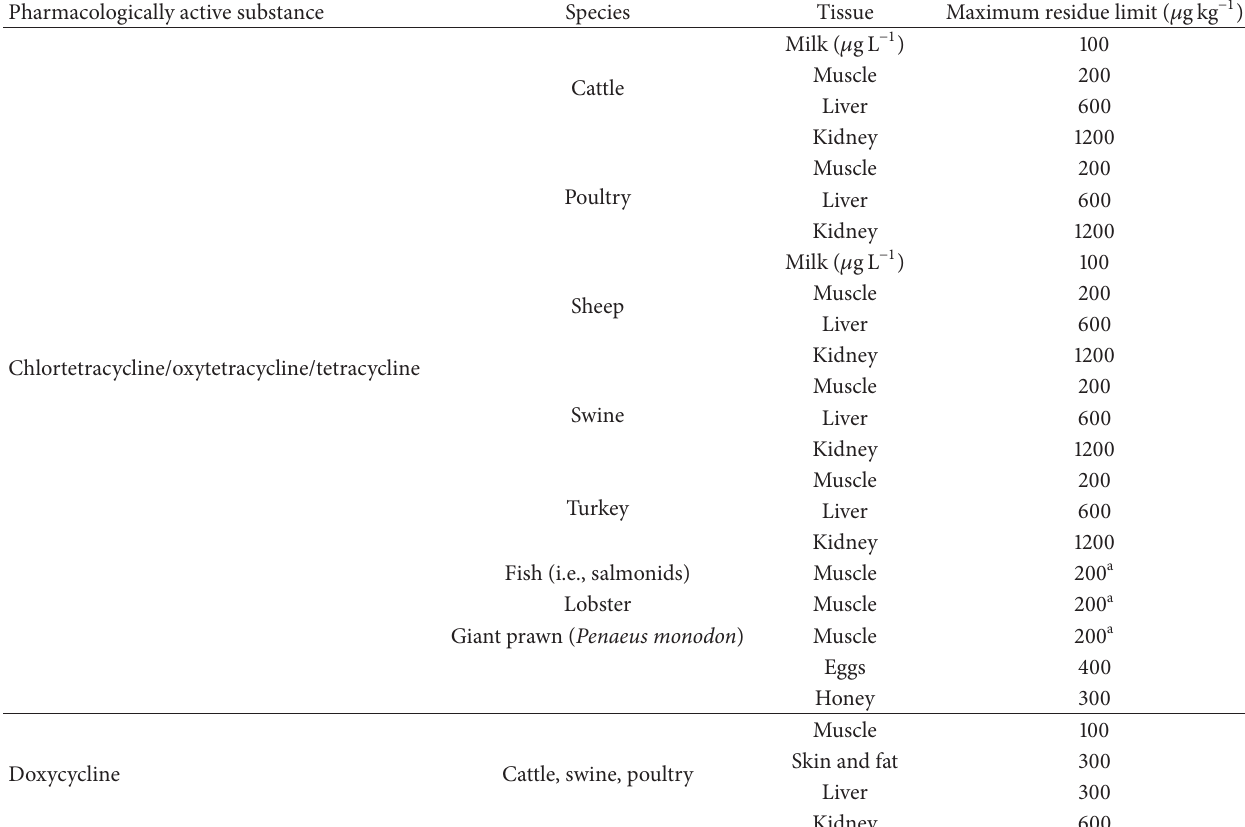
Table 3: Legally bound threshold concentrations established for food commodities or particular animal